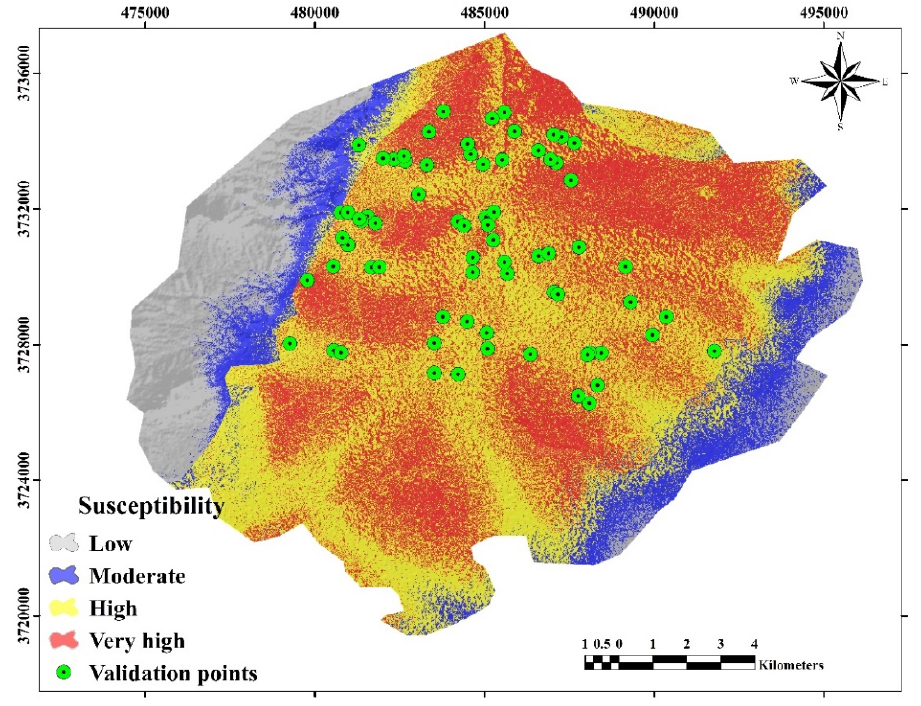
Figure 8. Gully erosion susceptibility map using the KNN model.